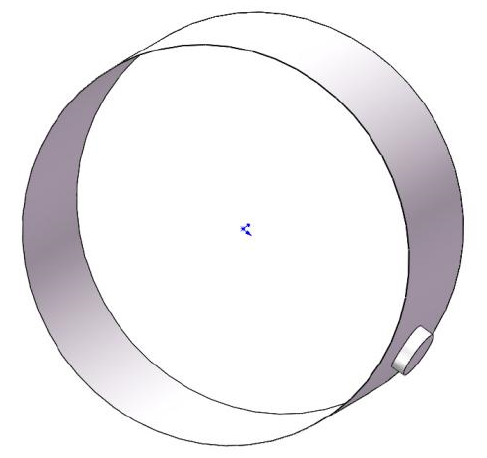
Figure 2. Three-dimensional model of the oil film. The boundary conditions are as